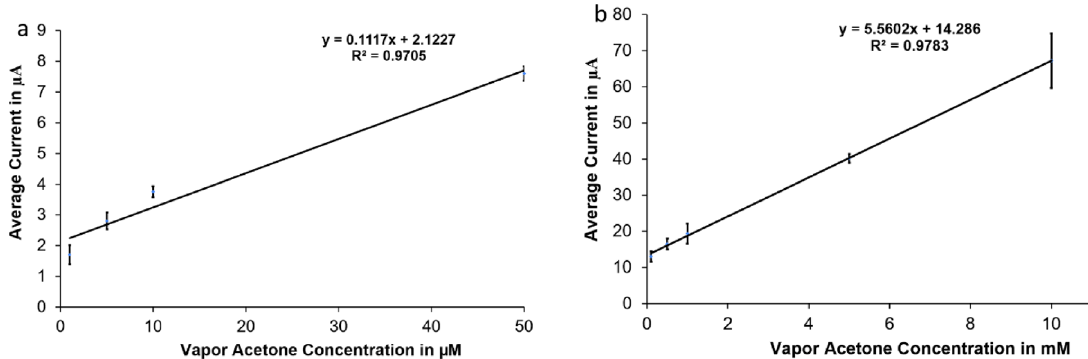
Figure 5. Calibration curves for vapor acetone: ( a ) small range (from 1–50 µM) ( b ) big range (0.5–10